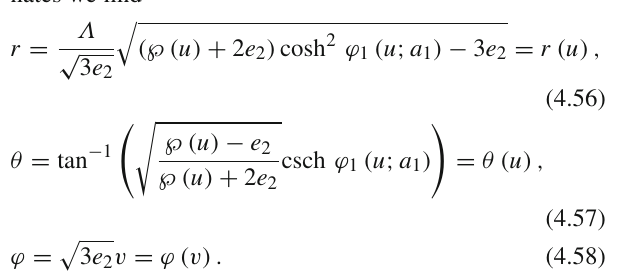
Fig. 8 The catenoid minimal surface in global and Poincaré coordi- nates be identified by these parameters for this class of